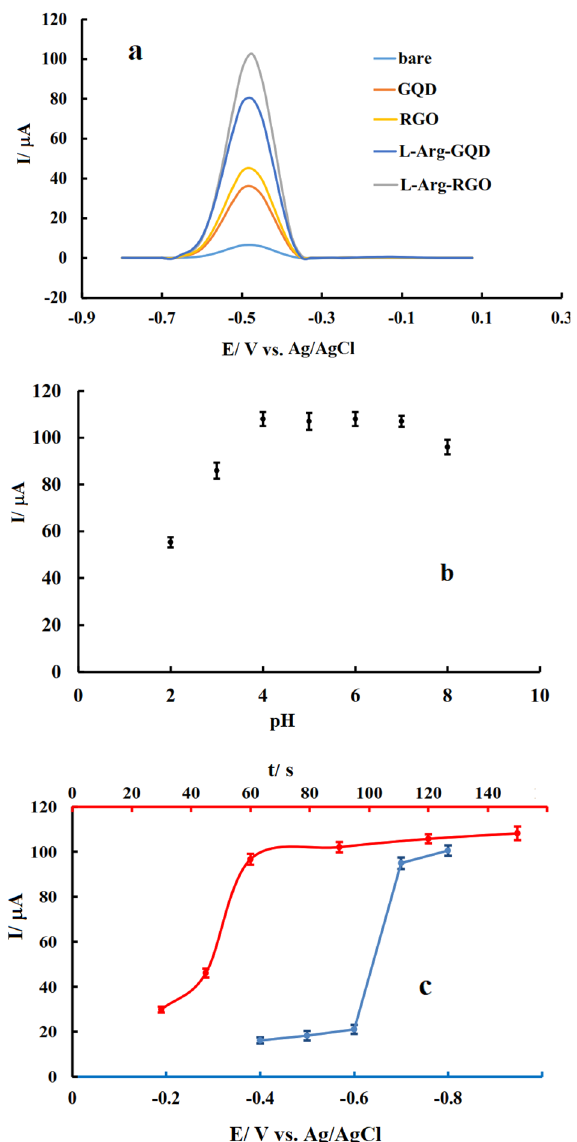
Figure 8. Differential pulse voltammograms of bare and modified GCEs recorded after preconcentration in 3 nM Pb(II) with pH 6 applying − 0.8 V for 60 s ( a ); Variation of DPV signal of l-Arg-RGO/GCE recorded after preconcentration in 3 nM Pb(II) with various pH values applying − 0.8 V for 60 s ( b ), Variation of DPV signal of l-Arg-RGO/GCE recorded after preconcentration in 3 nM Pb(II) with pH 6 applying − 0.8 V for different times (time optimization) or different potentials for 60 s (optimization of potential) ( c ). Scan rate: 0.1 V s −1 . Stripping condition: Pb(II) free KCl solution with pH